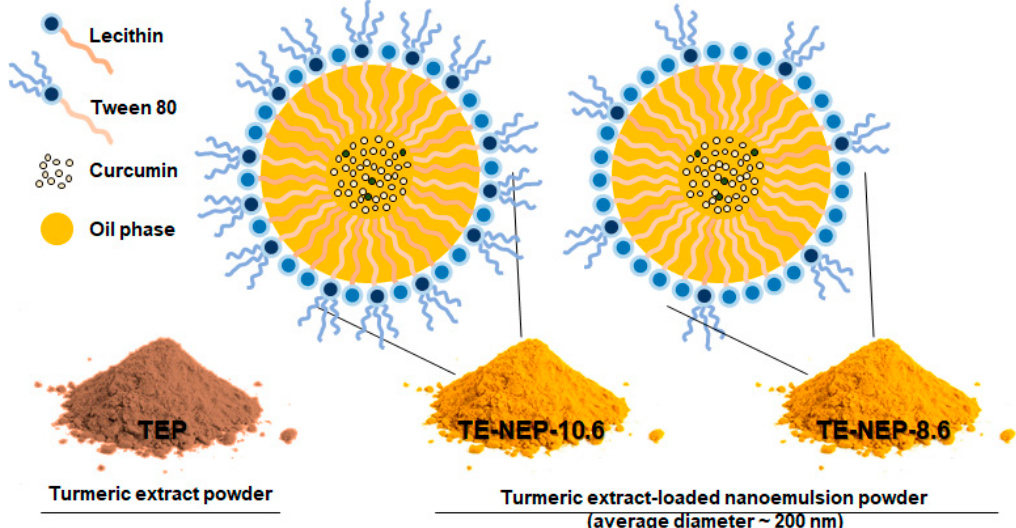
Figure 1. Schematic of o/w nanoemulsion including curcumin. Turmeric extract-loaded nanoemulsion powder (TE-NEP) was prepared using Turmeric extract powder (TEP). TE-NEP-10.6 has a HLB value of 10.6, and TE-NEP-8.6 has a HLB value of 8.6. Abbreviations: o/w, oil in water; HLB, hydrophilic lipophilic balance. Table 1. Composition of turmeric extract-loaded nanoemulsion powder (TE-NEP).